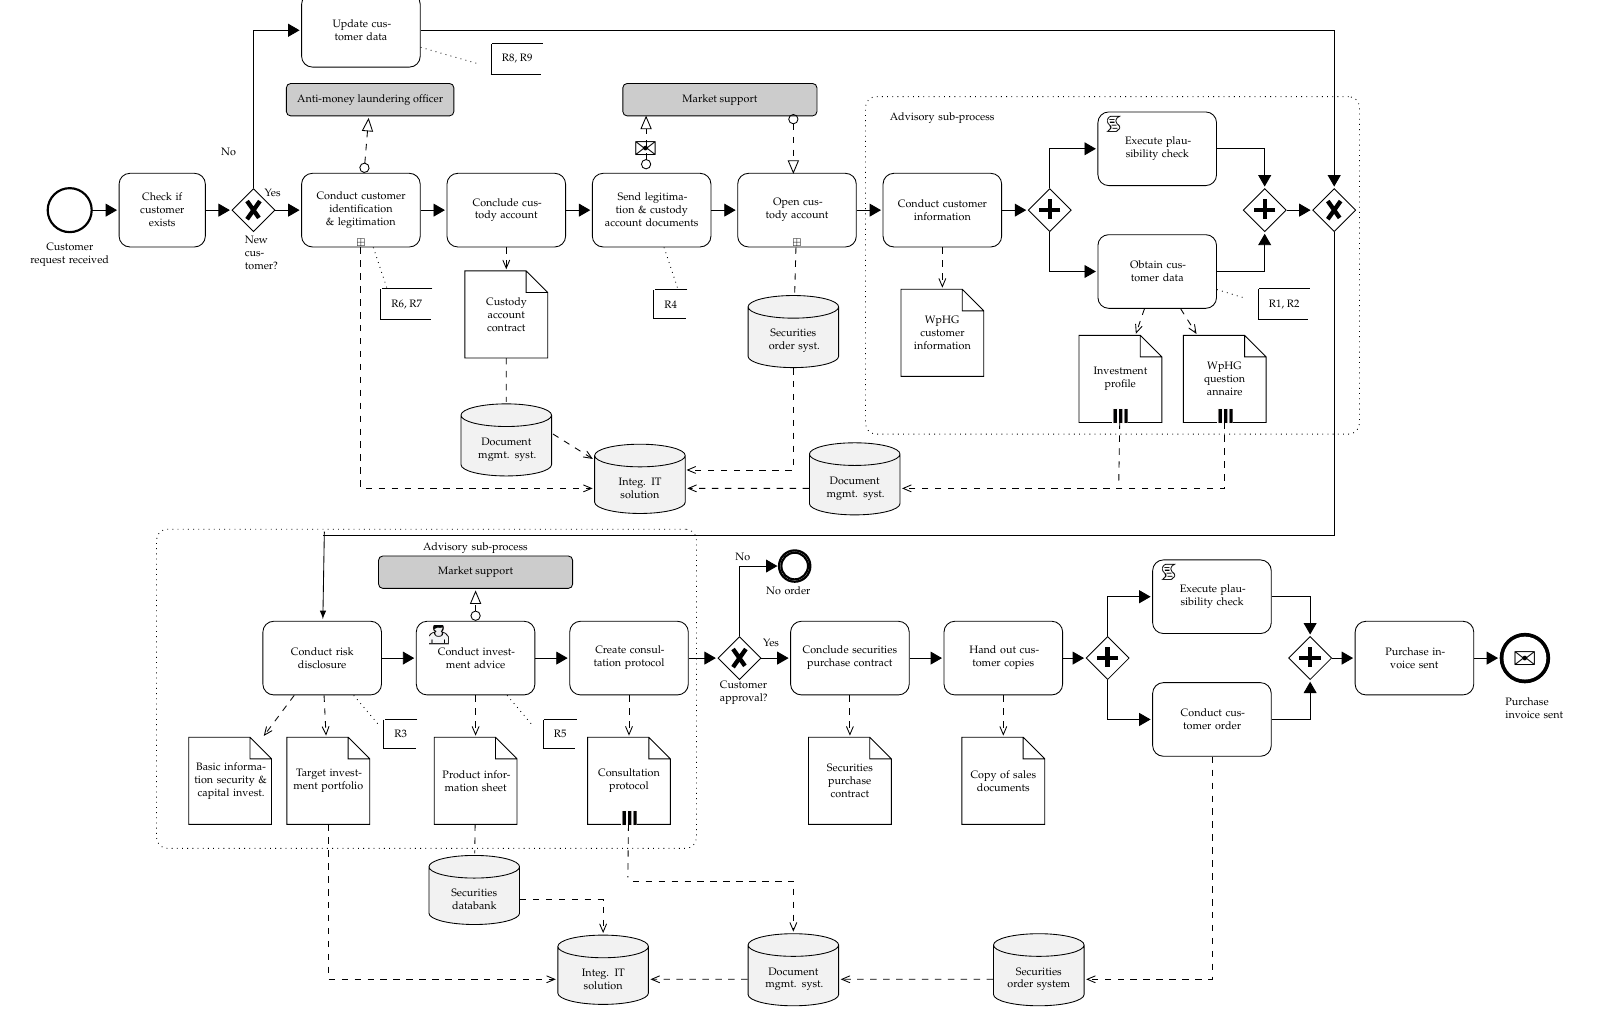
Figure 3. BPMN model of the securities purchase